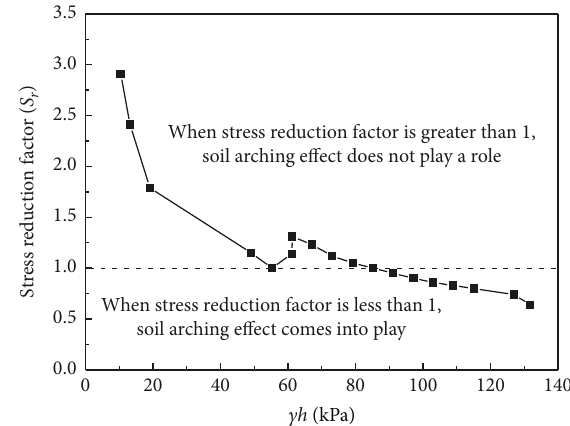
Figure 4: Relationship between stress reduction factor S